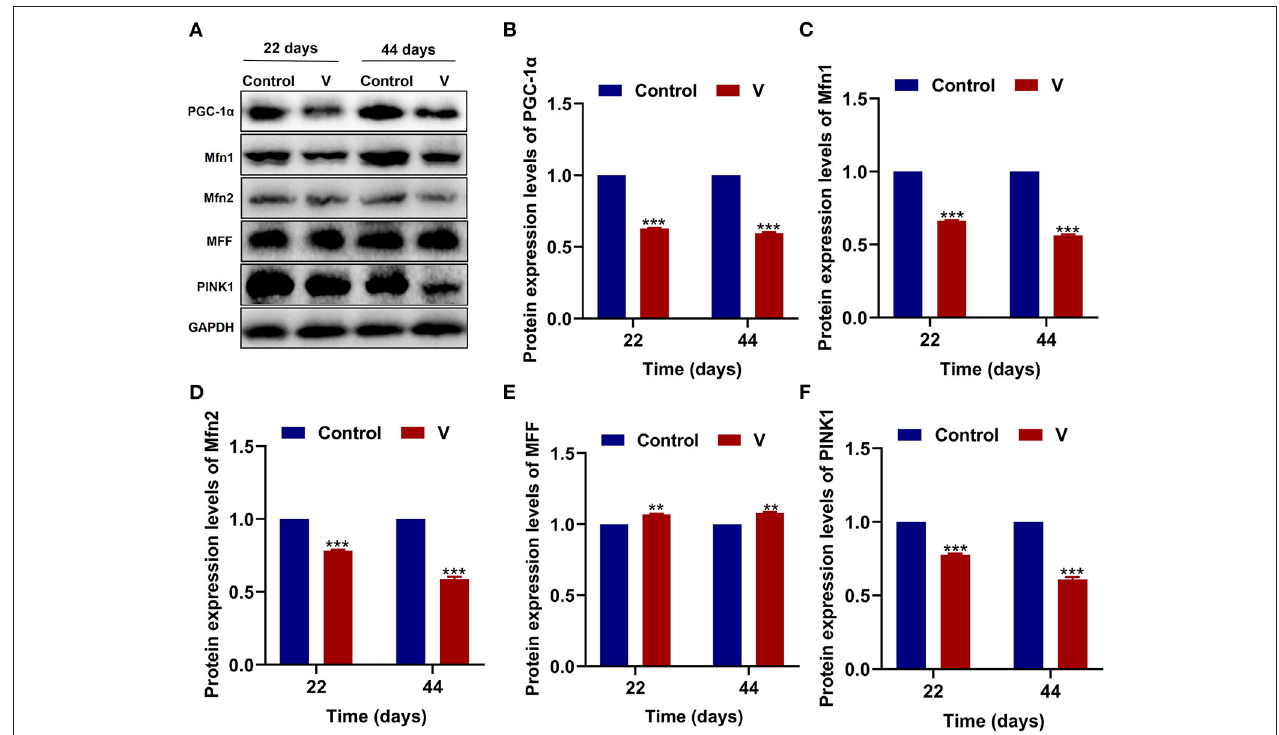
FIGURE 6 | The effects of V on MQC-related proteins in the heart of ducks. (A) Protein band graph. (B–F) Protein levels of PGC-1 α , Mfn1, Mfn2, MFF, and PINK1. ** p < 0.01 and *** p <